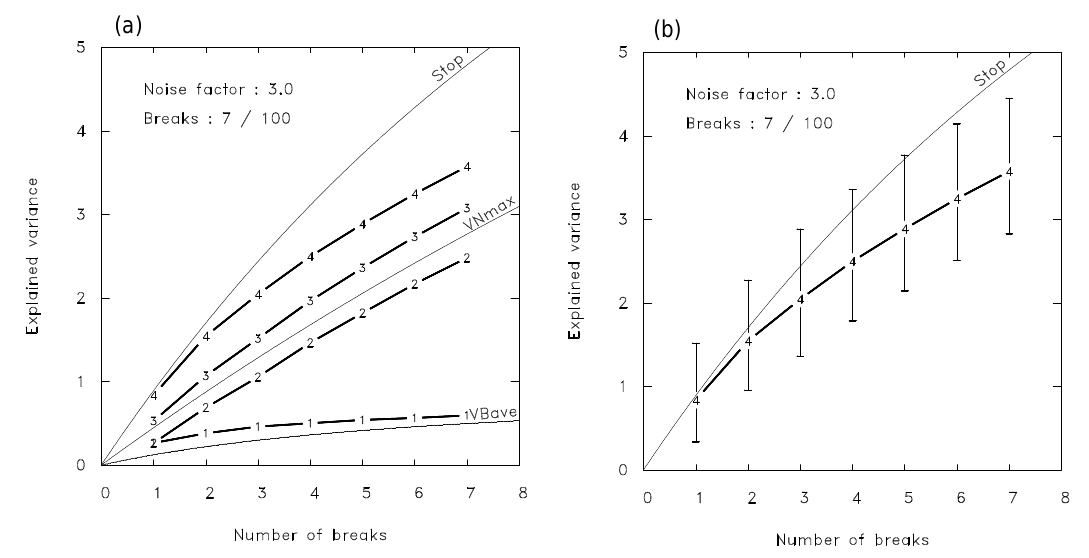
Figure 9. (a) Explained variances of breaks and noise, and the total explained variance, calculated from 1000 realizations. The explained variance for the breaks only is denoted by 1, the noise only by 2, the sum of these two terms by 3, and the total explained variance by 4. Equations (6), (8), and (16) are given as thin lines for orientation showing V Nmax , V Bave , and the stop criterion, respectively. (b) As (a) , but including also the variability of curve 4 and omitting the other curves. The whiskers denote the 1st and 9th deciles,